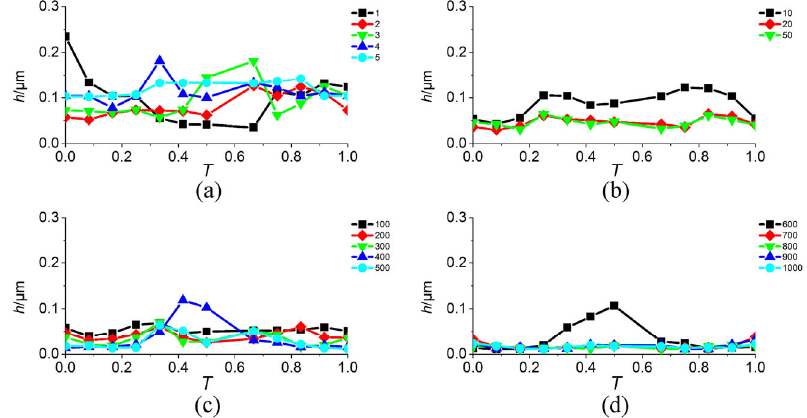
Fig. 9 Variation of minimum film thickness in some typical working periods ( v max = 0.01 m/s, w = 15 N, T = 0.5 s, L = 1.25 mm).